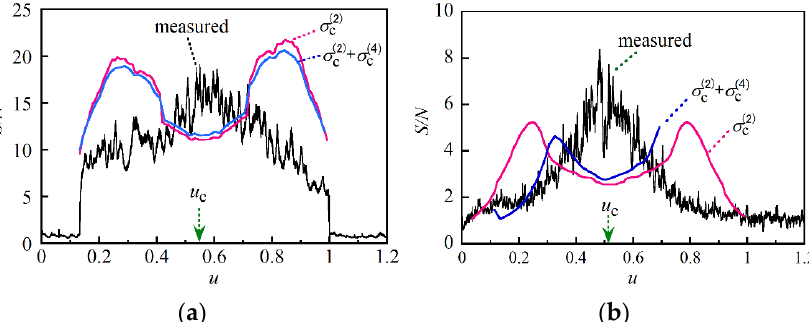
Figure 14. Comparison of measured and calculated S/N along ( a ) 10 m long and ( b ) 40 m long polarization-maintaining (PM) fibers. In each figure, the S/N distribution shown in black was obtained from distributions acquired by sweeping the tunable laser 30 times. The ratio < Z c > /√ σ c(2) as a function of u was calculated and plotted with a red line. The correction term σ c(4) is expressed by the sum of the eight terms A to H , which were represented by Equations (A67) to (A74) in Appendix E, respectively. The ratio < Z c > /√( σ c(2) + σ c(2) ) as a function of u was calculated and plotted with a blue line. The employed parameters were ( a ) Δ rms = 3.74×10 6 rad/s, τ e = 115 ns, u c = 0.545. ( b ) Δ rms = 5.65×10 6 rad/s, τ e = 402 ns, u c = 0.515.